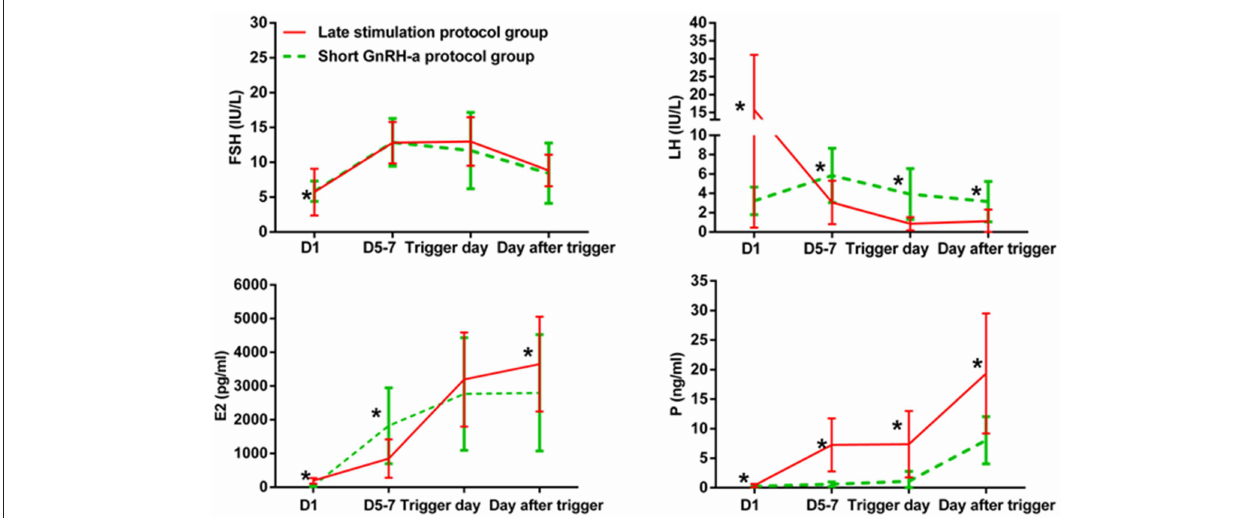
FIGURE 3 | Serum hormone profiles during ovarian stimulation in the two groups. The green lines represent the control group (short GnRH-a protocol group), and the red lines represent the study group (late stimulation protocol group). The day of starting ovarian stimulation is denoted as day 1 (D1). FSH, follicle-stimulating hormone; LH, luteinizing hormone; E 2 , estradiol; P, progesterone. *time point at which P < 0.05.